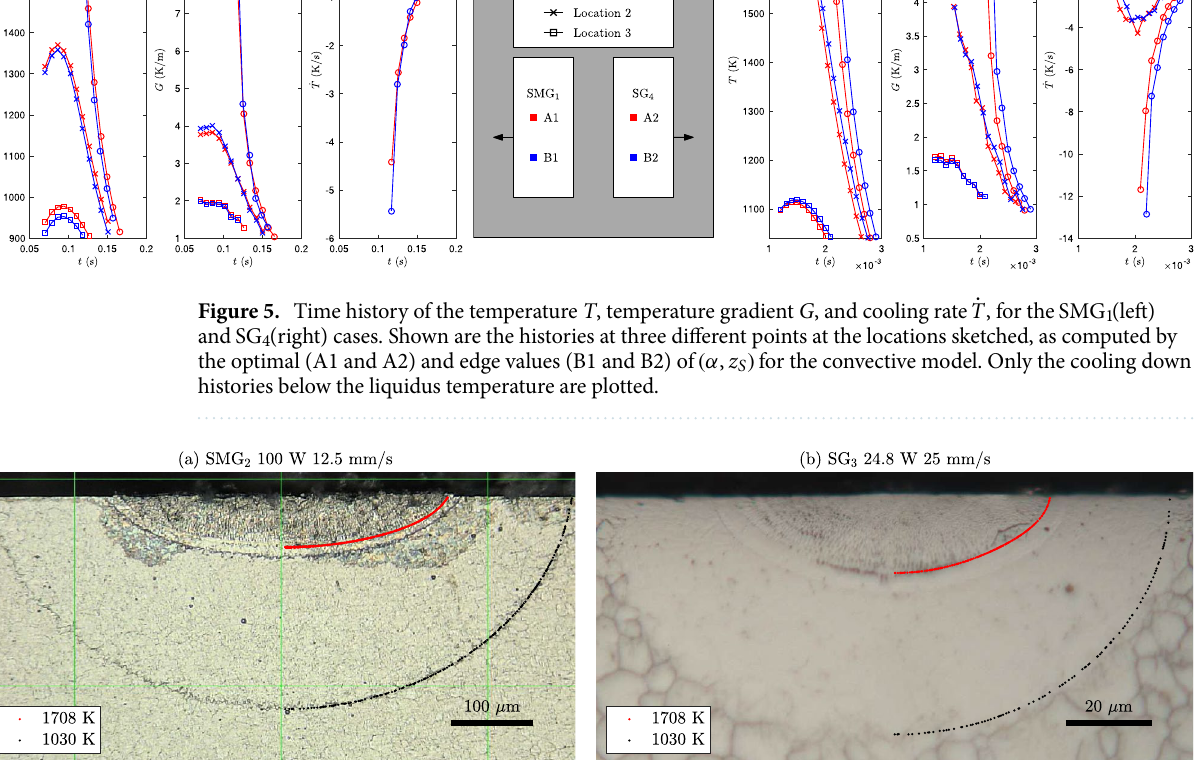
Figure 6. Trace of the boundary of the heat affected zones (HAZ), seen as a jagged line in SMG 2 and as the place where grain boundaries become faint in SG 3 . The traces of two isotherms are shown computed with the optimal values of (α , z S ) and the convective model in each case. These include the liquidus isotherm (red) and the 1030 K -isotherm (black). The HAZ boundary coincides with the trace of an isotherm in both